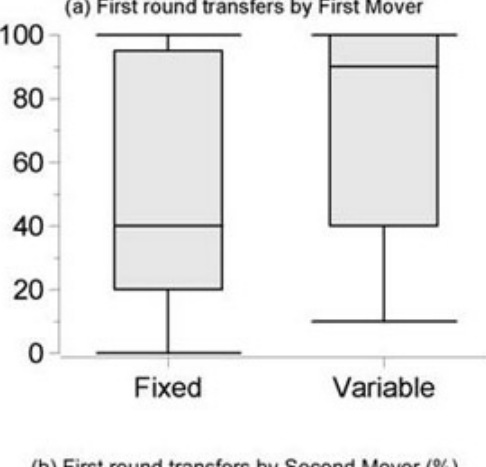
Fig. 2. First round transfers within ‘fixed’ and ‘variable’ multiplier treatments, from (a) first to second mover, and (b) second to first mover as a percentage of transfers received. Transfers are per participant, averaged across all rounds. Data shown as box-whisker plots with median, 25, and 75 percentile ranges and outliers, and with the horizontal bars showing minimum and maximum excluding